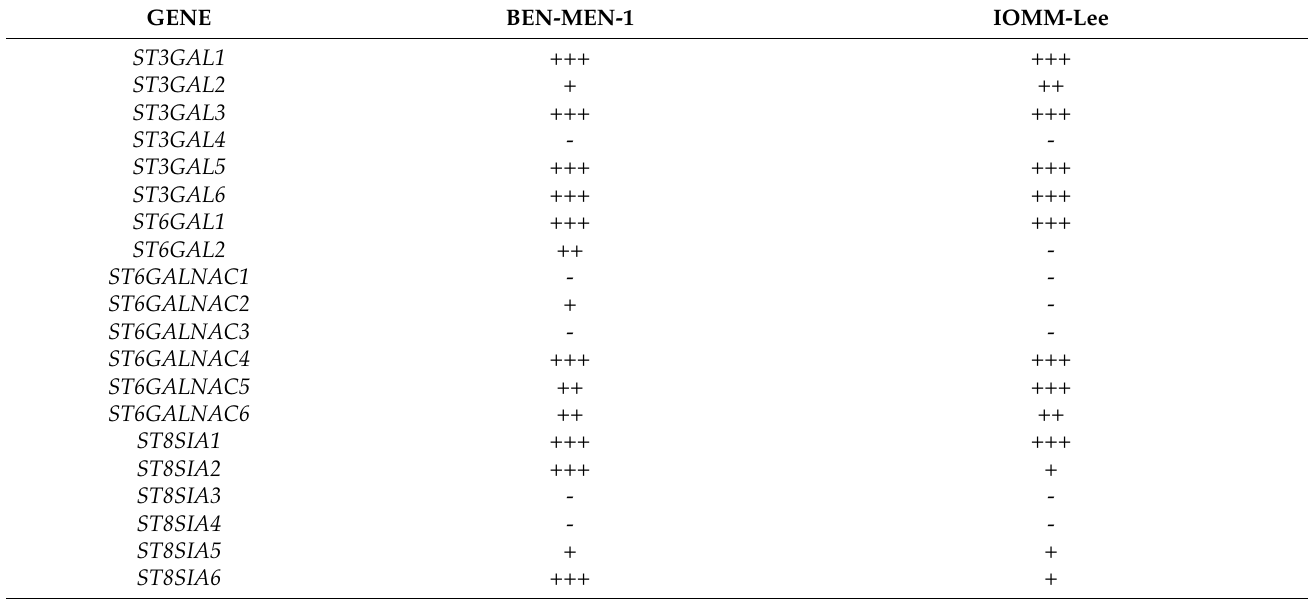
Table 1. Overview of sialyltransferase expressions in both meningioma cell lines.